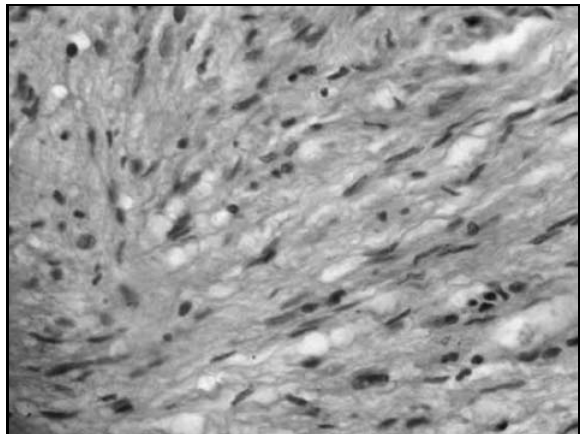
Figura 5 – Aspecto microscópico (HE, 40x)